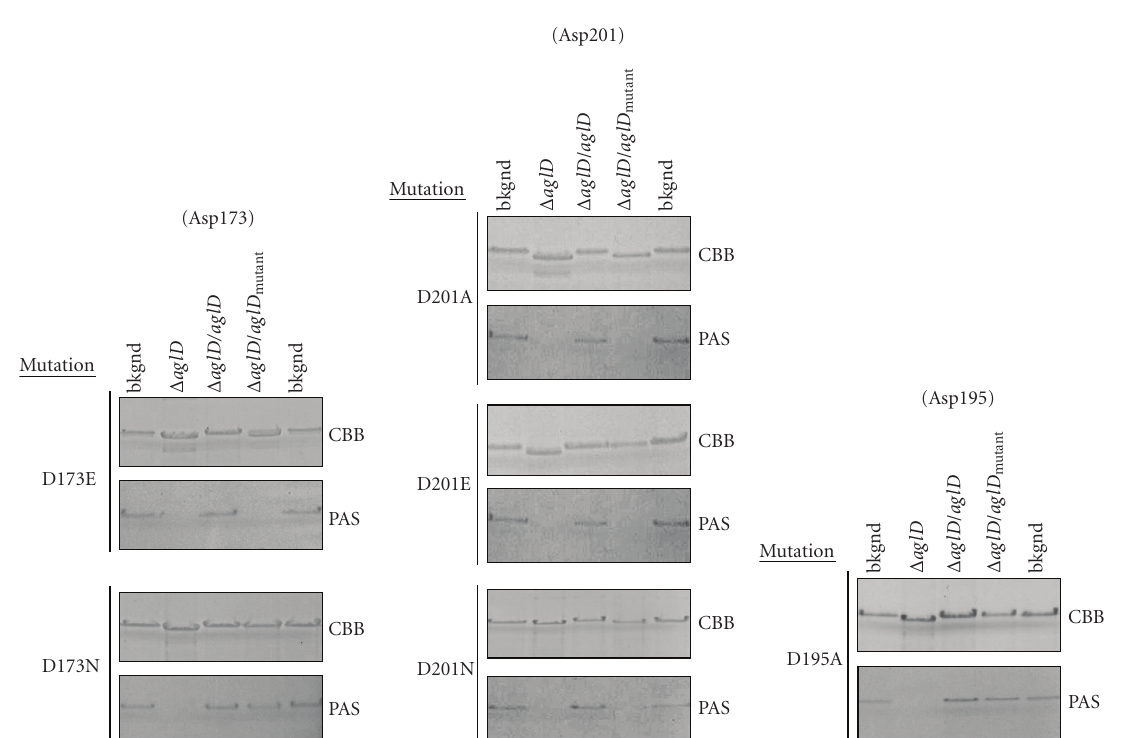
Figure 4: Hfx. volcanii AglD Asp201 is apparently the catalytic base of the enzyme. Site-directed mutagenesis was performed to generate CBD-AglD containing mutations of Asp173 (upper left column), Asp195 (lower left column), and Asp201 (right column), as listed on the left of each panel. For each mutant, the upper and lower panels, respectively, show the Coomassie- and PAS-stained S-layer glycoprotein from the background strain (lanes 1 and 5), from the aglD deletion strain (lane 2), from the aglD deletion strain complemented with a plasmid encoding CBD-AglD (lane 3), or from the aglD deletion strain complemented with a plasmid encoding CBD fused to mutated AglD (lane